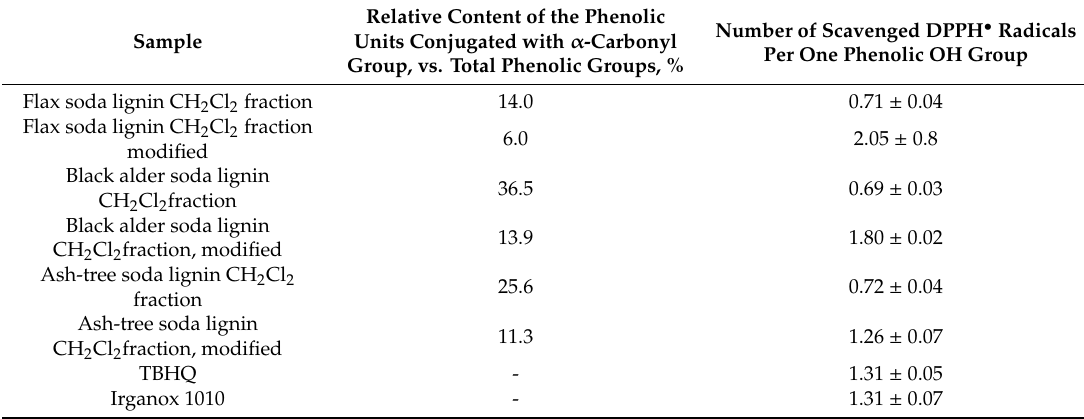
Table 4. Relative content of the phenolic units conjugated with α -carbonyl group given with respect to the total OH phenolic and antioxidant activity of